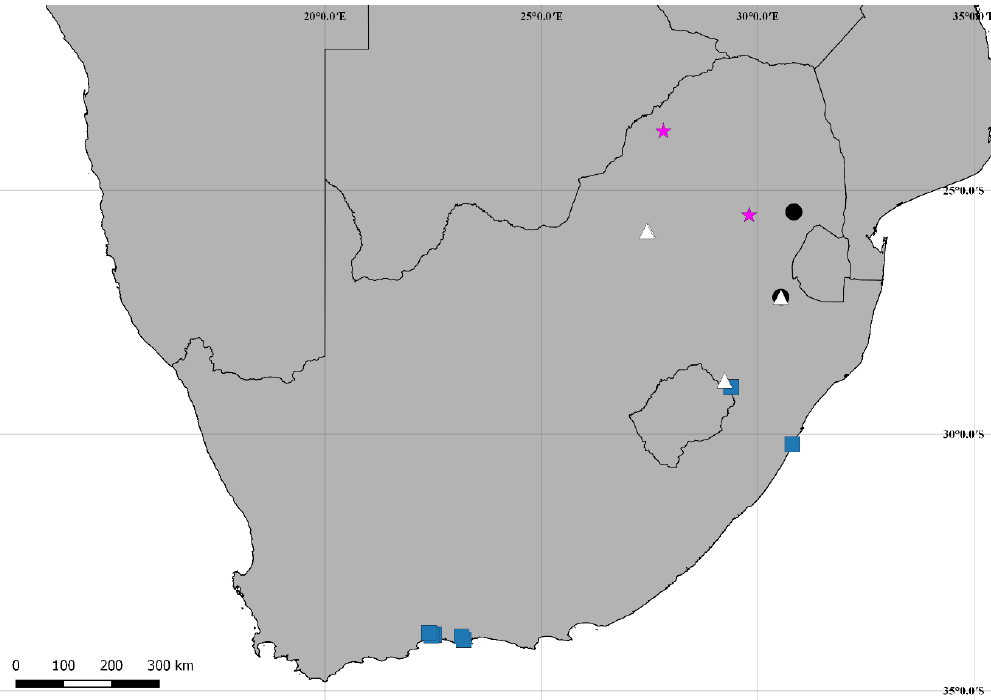
Figure 14. Known distribution of Cis foveocephalus sp. n. (white triangle), Cis grobbelaarae sp. n. (pink star), Cis parvisetosus sp. n. (blue square) and Cis tessariplacus sp. n. (black circle).